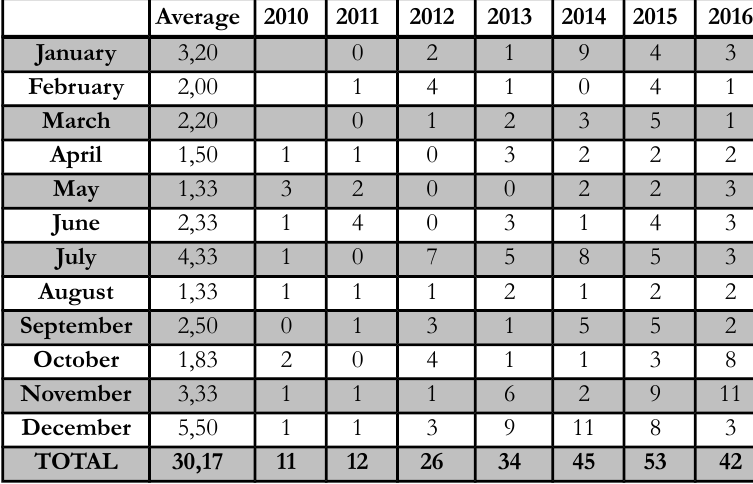
Table 1. Article submission evolution from 2010 to 2016